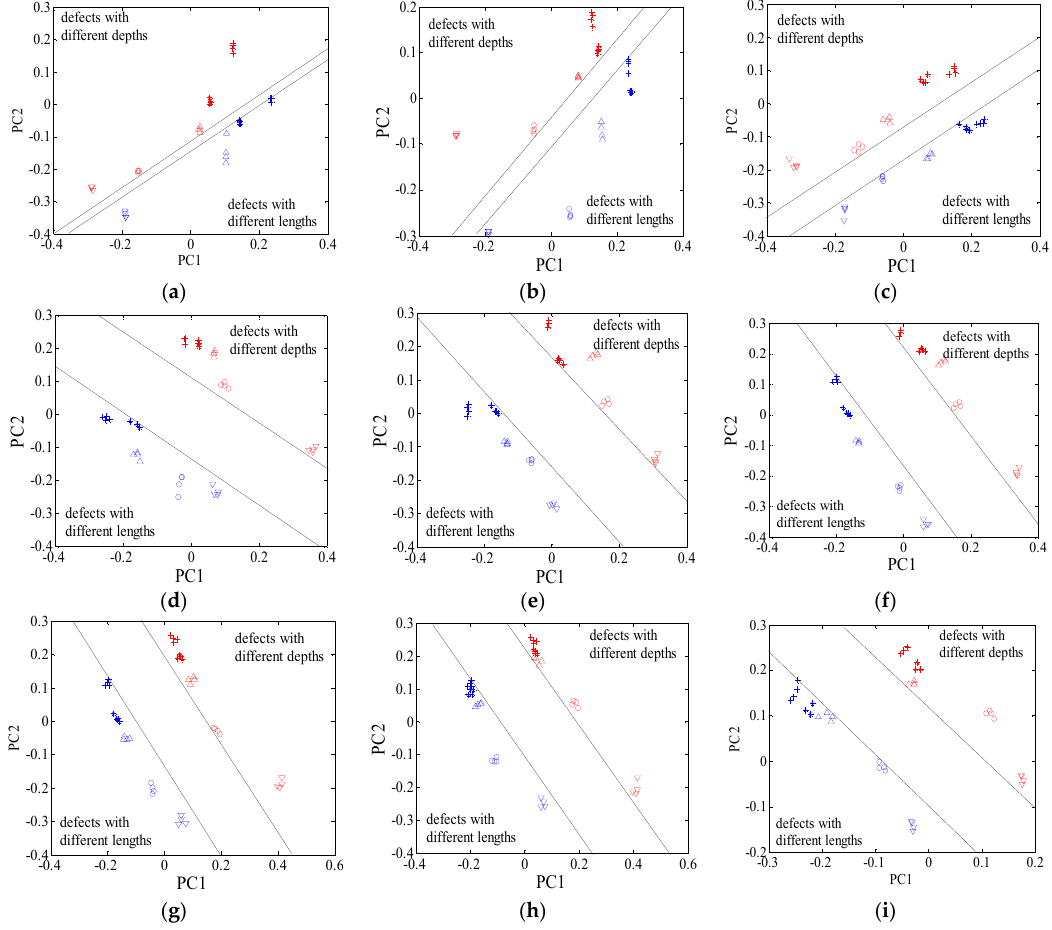
Figure 5. Defect features under different frequencies. ( a ) 50 kHz; ( b ) 150 kHz; ( c ) 250 kHz; ( d ) 350 kHz;